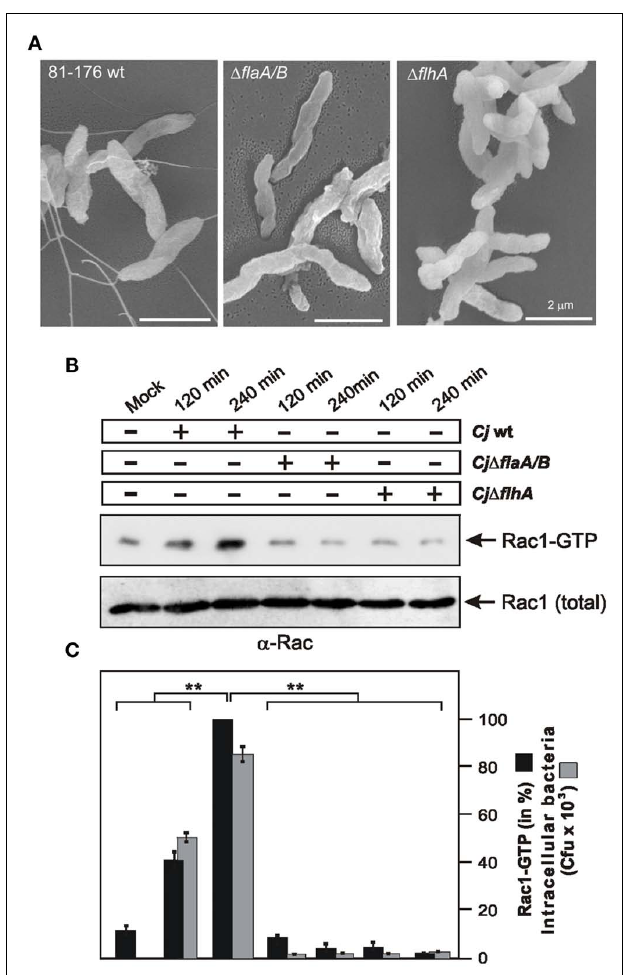
FIGURE 7 | Importance of the flagellar apparatus for C. jejuni -induced activation of Rac1 and bacterial invasion. (A) High resolution field emission scanning electron microscopy of C. jejuni WT 81–176, 81–176 Δ flaA/B, and 81–176 Δ flhA mutants. (B) FAK-positive cells were infected with the indicated strains in a time course.The presence of bound, active Rac1-GTP was analyzed in CRIB–GST pull-down assays followed by Western blotting using α -Rac1 antibody. Similar quantities of individual GTPases at every time point were confirmed byWestern blotting using equivalent volumes of cell lysates. (C) Quantification of Rac1-GTP levels during the course of infection. One hundred percentage of activity corresponds to the highest amount of detected GTPase-GTP level.The amount of intracellular bacteria was quantified by gentamicin protection assays.